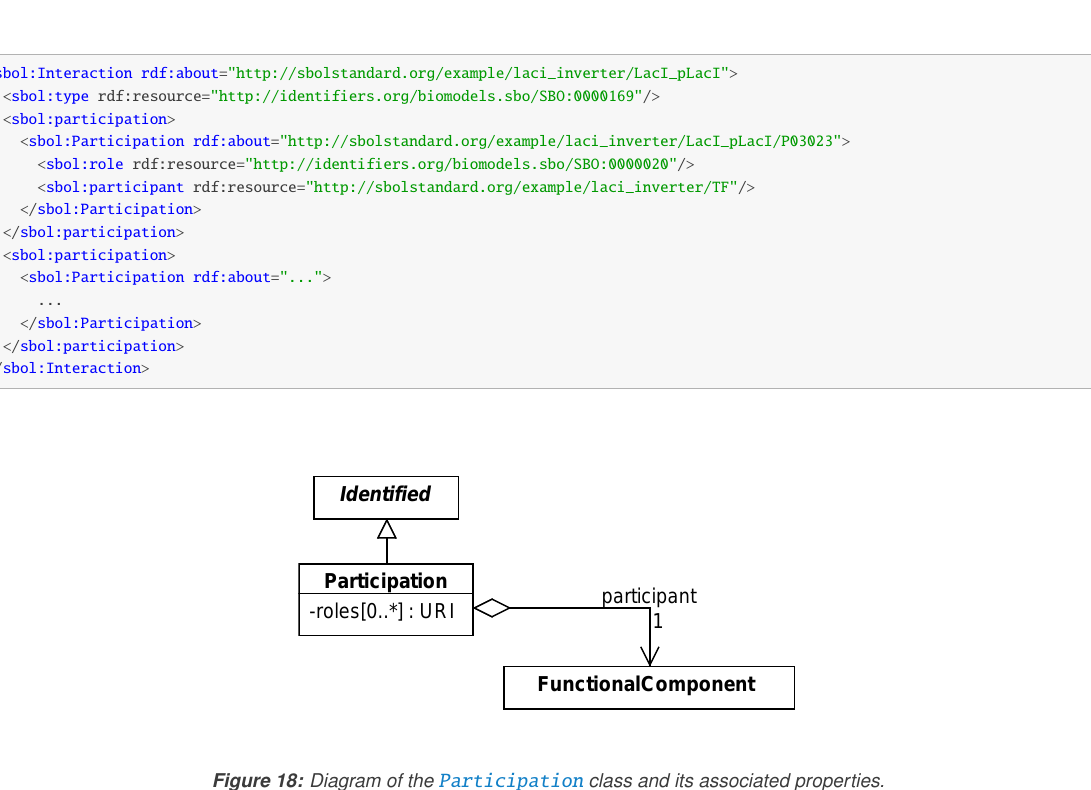
Figure 18: Diagram of the Participation class and its associated properties.